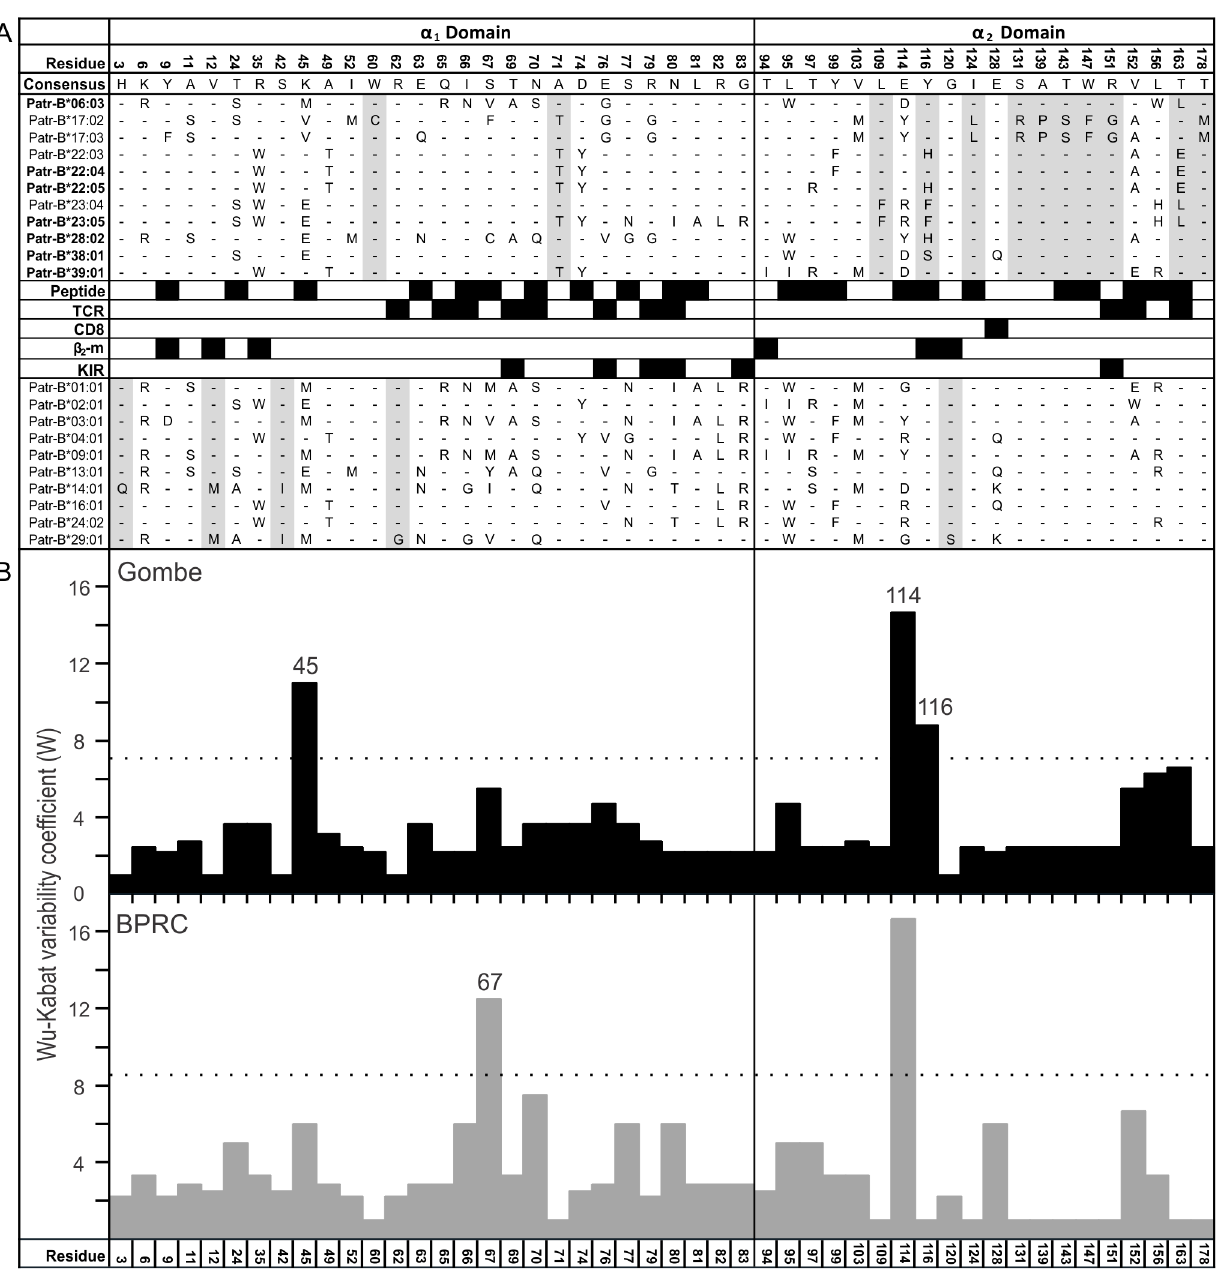
Fig 5. Extensive amino acid sequence polymorphism in the Patr-B allotypes of the Gombe and BPRC chimpanzees. (A) Displayed are the amino acid sequence differences that distinguish the α 1 and α 2 domains of Gombe P. t. schweinfurthii (upper group) and BPRC P. t. verus (lower group) Patr-B allotypes. Only polymorphic positions are included. Identity to the consensus is denoted by a dash. For amino acid differences from the consensus, the residue is shown. The black-filled boxes between the two sets of sequences show which residues contribute to binding sites for peptide, T cell receptor (TCR), CD8 T- cell coreceptor (CD8), KIR and the invariant β 2 -microglobulin subunit ( β 2 -m) of the MHC class I molecule. In bold are the names of “ novel ” alleles, which were discovered in the Gombe population. Positions highlighted in gray are polymorphic in one population but not the other. (B) Histograms showing the value of the sequence variability coefficient, W, for the Gombe (upper) and BPRC (lower) Patr-B allotypes. The histograms are in vertical alignment with the sequence alignment in (A). For each population, the horizontal dashed lines mark the value for W that is twice the mean W value for all polymorphic residues in the